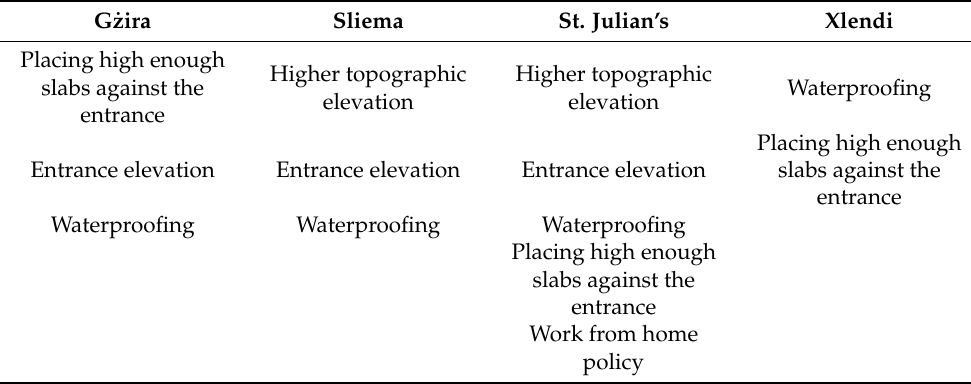
Table 4. Inventory of preventive/adaptation